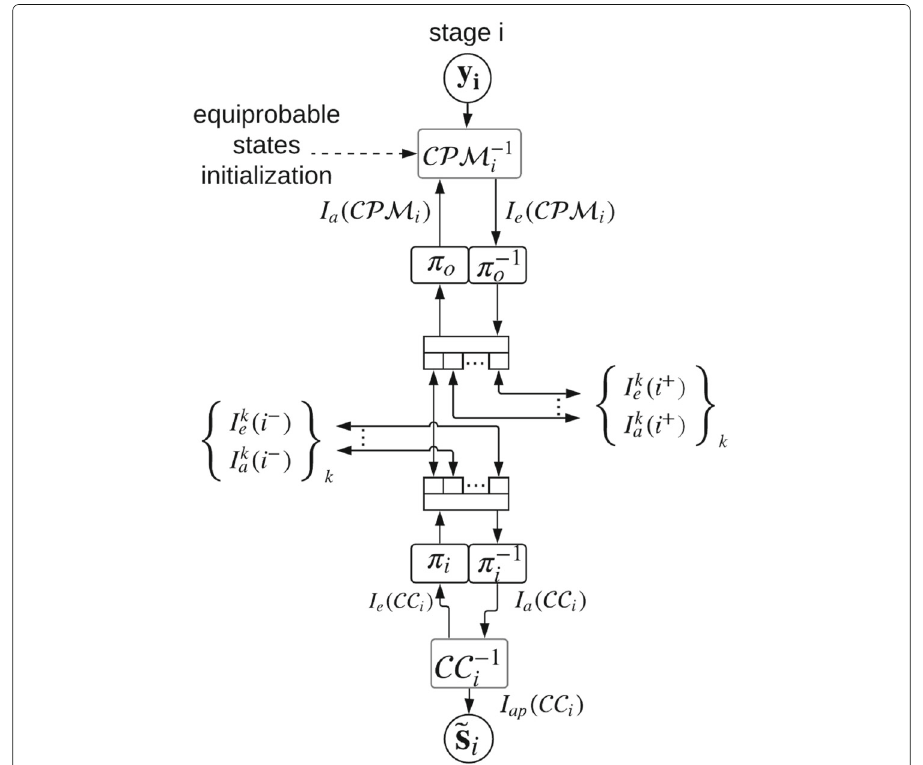
Fig. 6 The vectorized graph of the i th stage of the terminated SC-CPM